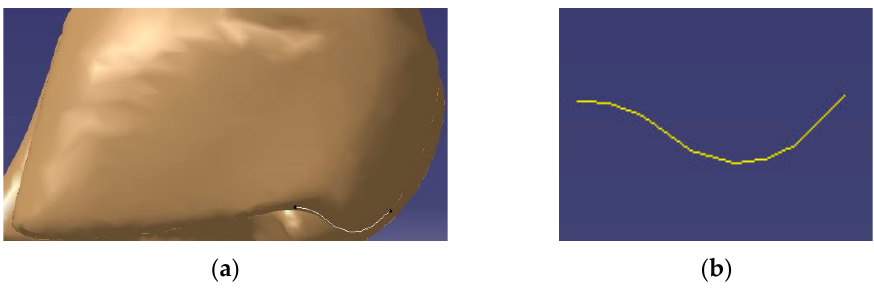
Figure 1. Biological prototype: ( a ) 3D model of a goat hoof and ( b ) bionic curve.